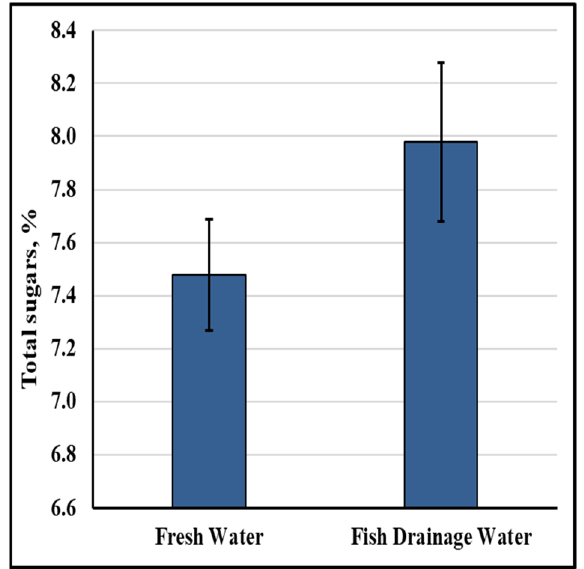
Figure 5. Effect of freshwater and fish drainage water in combination with different organic fertilizer types on total sugar content of the fruit juice. types on total sugar content of the fruit juice.